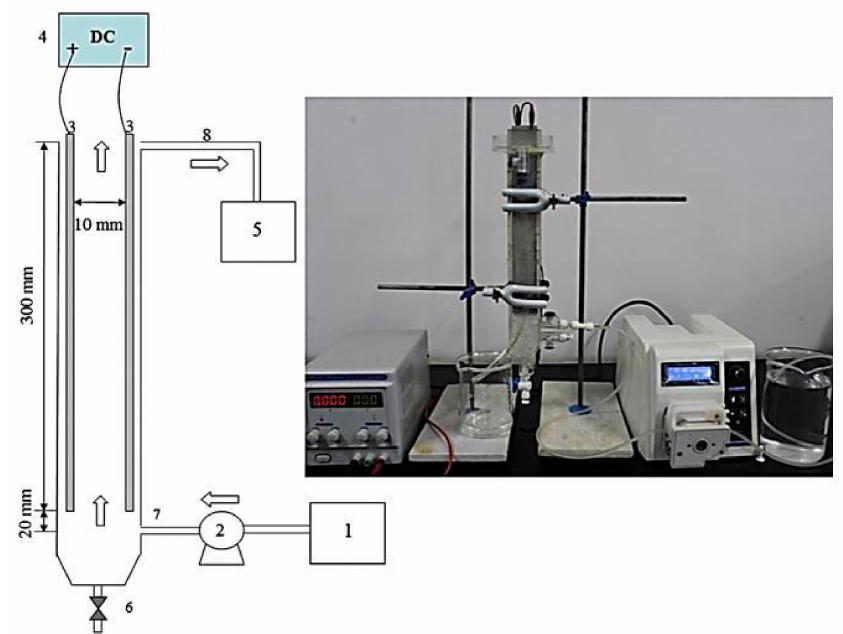
Figure 18. Schematic diagram and experimental set-up of EC process: (1) Raw water tank; (2) Peristaltic pump; (3) Aluminum electrodes; (4) DC power supply; (5) Outflow tank; (6) Sludge disposal; (7) Influent; (8) Effluent